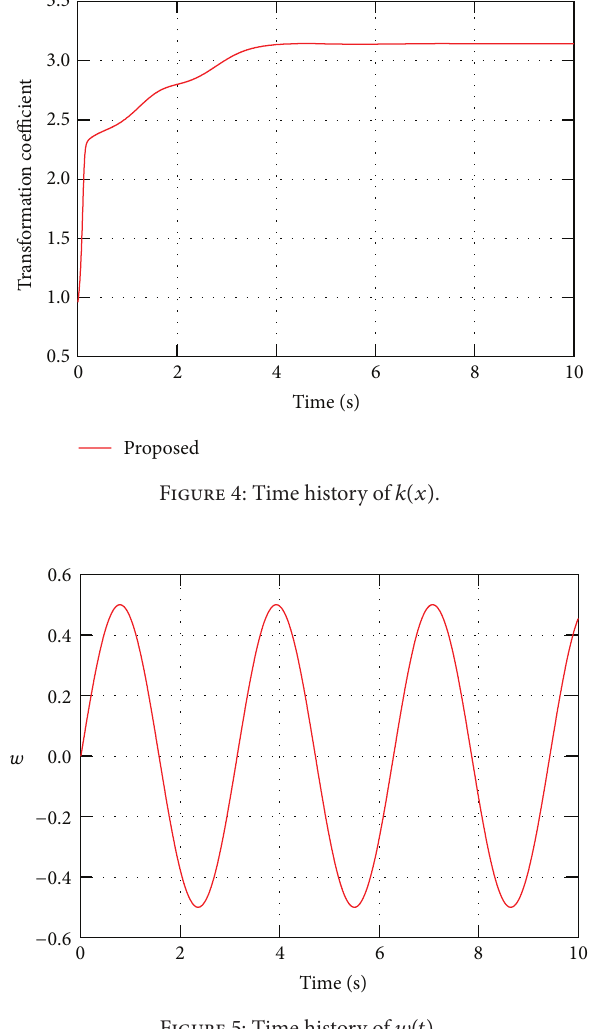
Figure 5: Time history of 𝑤(𝑡)